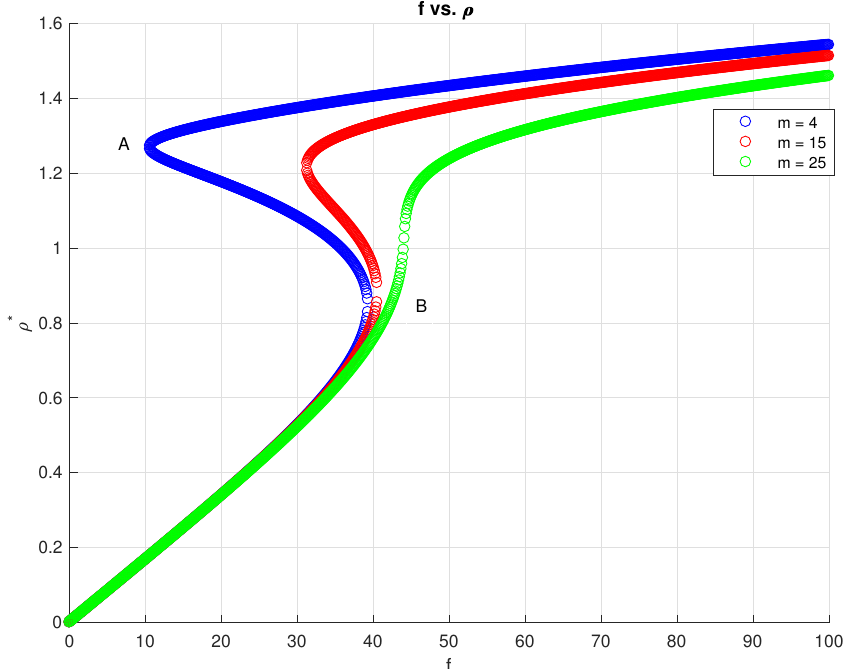
Figure 4. External Excitation Response Curve ( m 21 = 4,15,25 and µ 1 = 0.4, α 1 = 0.2, α 3 = 1.5, α 5 = 2, σ = 30, k =